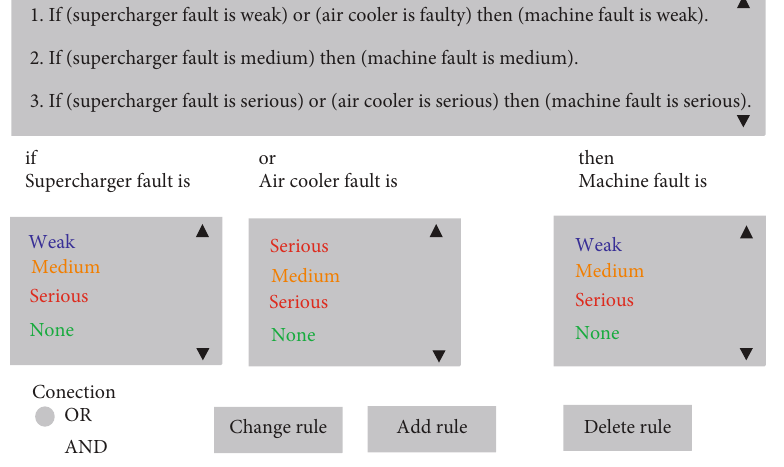
Figure 2: Intuitionistic inference system of the FDIFA semigroup for the engine fault.